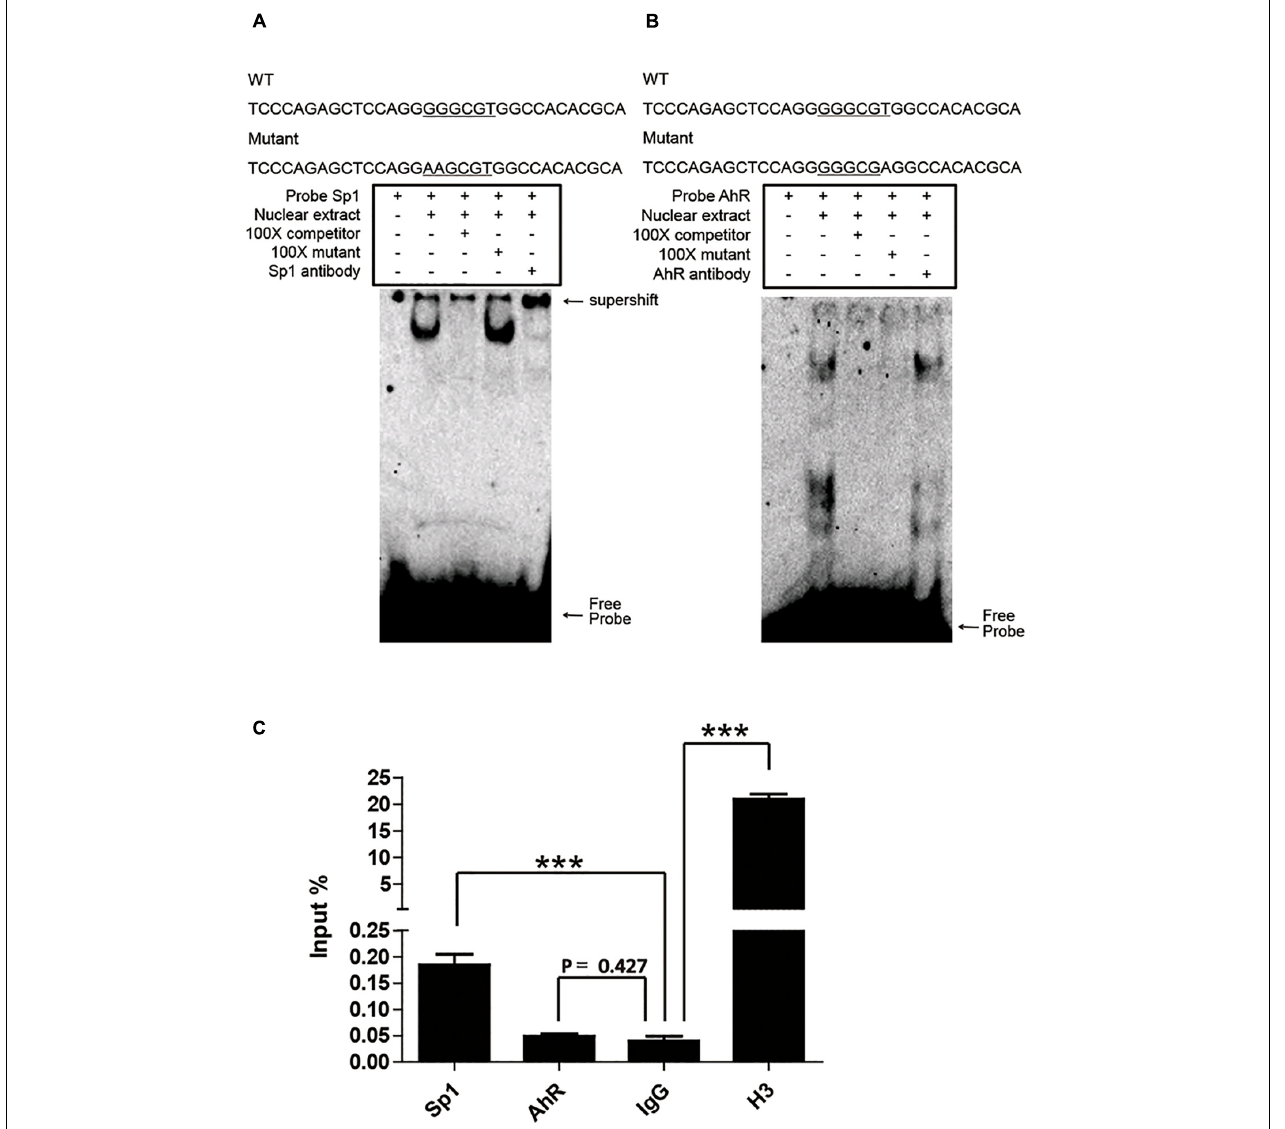
FIGURE 4 | Sp1 binds to the GC box and then affects the activity of the p CYP1A1 promoter. (A) EMSA was used to confirm that Sp1 binds to the GC box at the proximal p CYP1A1 promoter. (B) EMSA was used to confirm that AhR does not bind to XRE at the proximal p CYP1A1 promoter. The mutated bases are underlined. For the competition experiments, 100-fold molar excess of the unlabeled probe was used. The DNA protein complexes and supershifts are indicated by arrows. (C) ChIP was used to confirm that Sp1 or AhR binds to cis elements at the proximal p CYP1A1 promoter. IgG was used as the negative control. Histone H3 antibody served as the positive control. The experiment was repeated three times. Error bars represent the standard deviation of three replicates. ∗∗∗ P < 0.001.